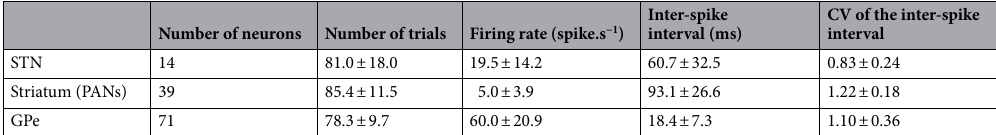
Number of neurons Number of trials Firing rate (spike.s −1 )